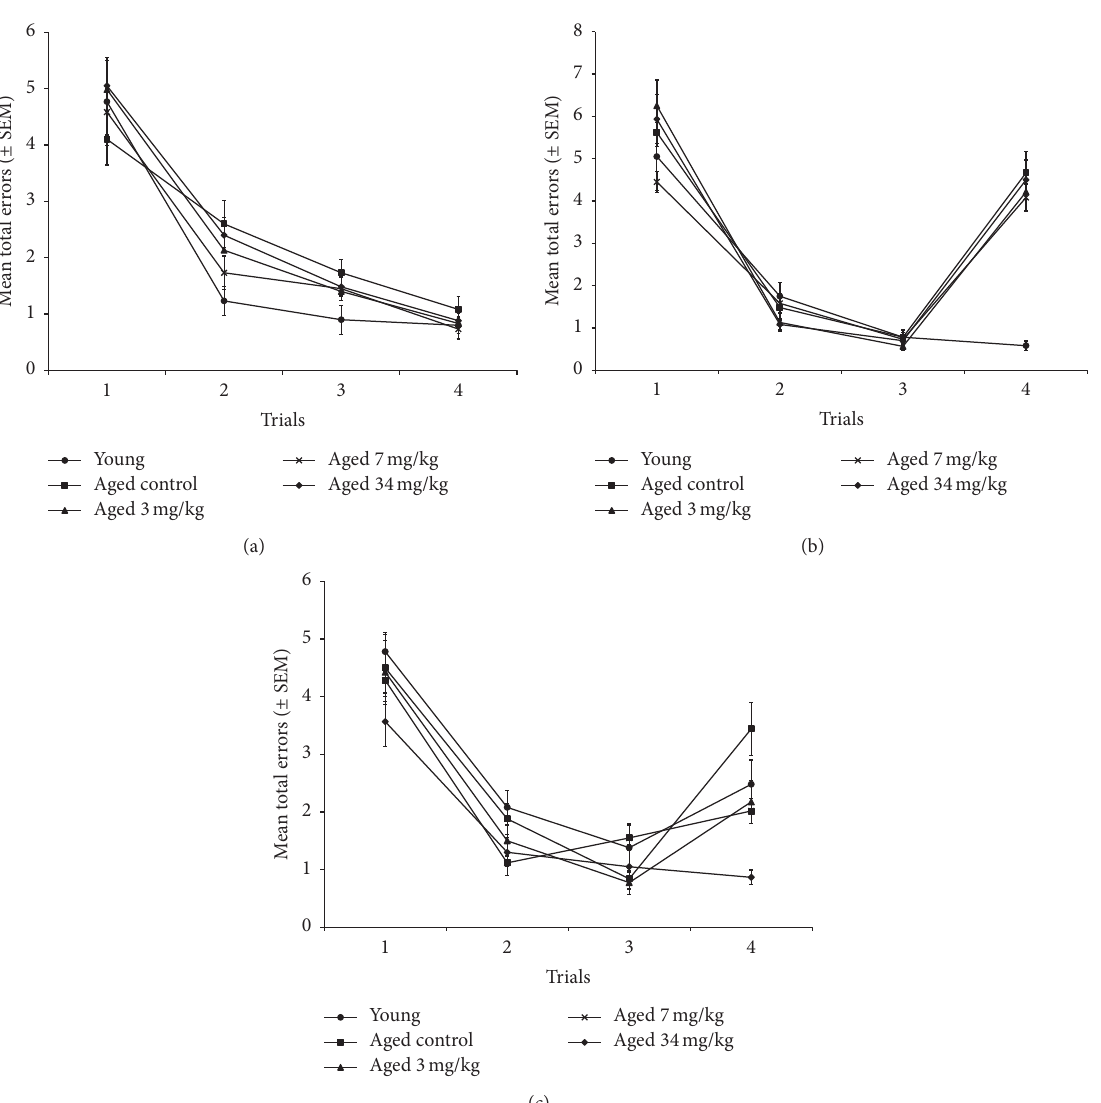
Figure 2: Radial arm water maze (RAWM) study. After initial training in the RAWM but before administration of UP326, aged rats were able to perform as well as their young cohorts (Figure 2(a)). But after a 3 hr delay was inserted between trials 3 and 4, the aged rats lost all trainingadvantages(Figure2(b)).AftertakingUP326for2months,alldosegroupsshowedsignificantimprovementattenuationofage-related memory impairments (Figure 2(c)). 12 rats per group were used for each